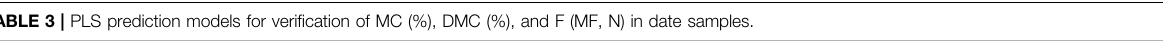
TABLE 3 | PLS prediction models for veri fi cation of MC (%), DMC (%), and F (MF, N) in date samples. Quality attributes Range